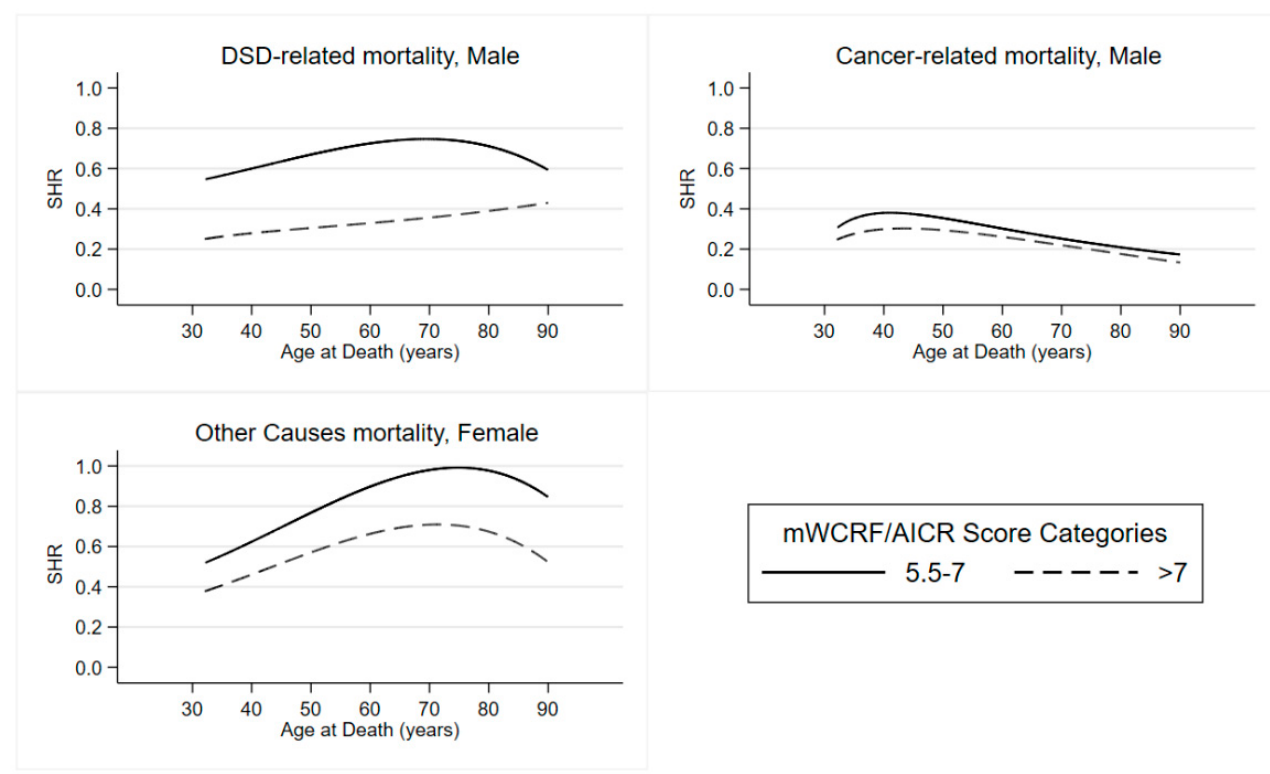
Figure 1. DSD-related mortality, Cancer-related mortality and Other Causes mortality Subdistribution Hazard Ratio. MICOL/PANEL and NUTRIHEP Studies. Castellana Grotte-Putignano (BA), Italy, 2005-2020. DSD: Digestive System Disease; SHR: Subdistribution Hazard Ratio.